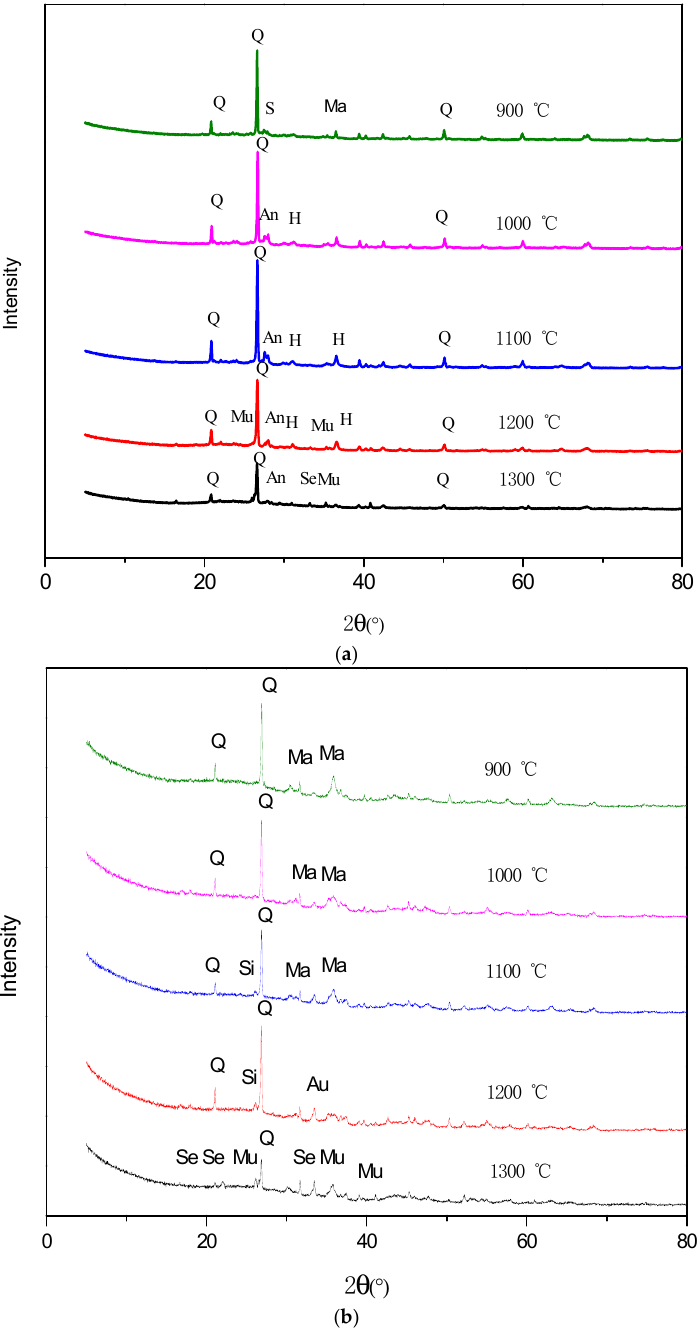
Figure 6. XRD patterns of the ash under reduced atmosphere (900–1300 °C). ( a ) Ulanqab lignite; ( b ) Ulankarma lignite. Q—quartz; Se—sekaninaite; Ma—magnetite; H—hercynite; An—anorthite;